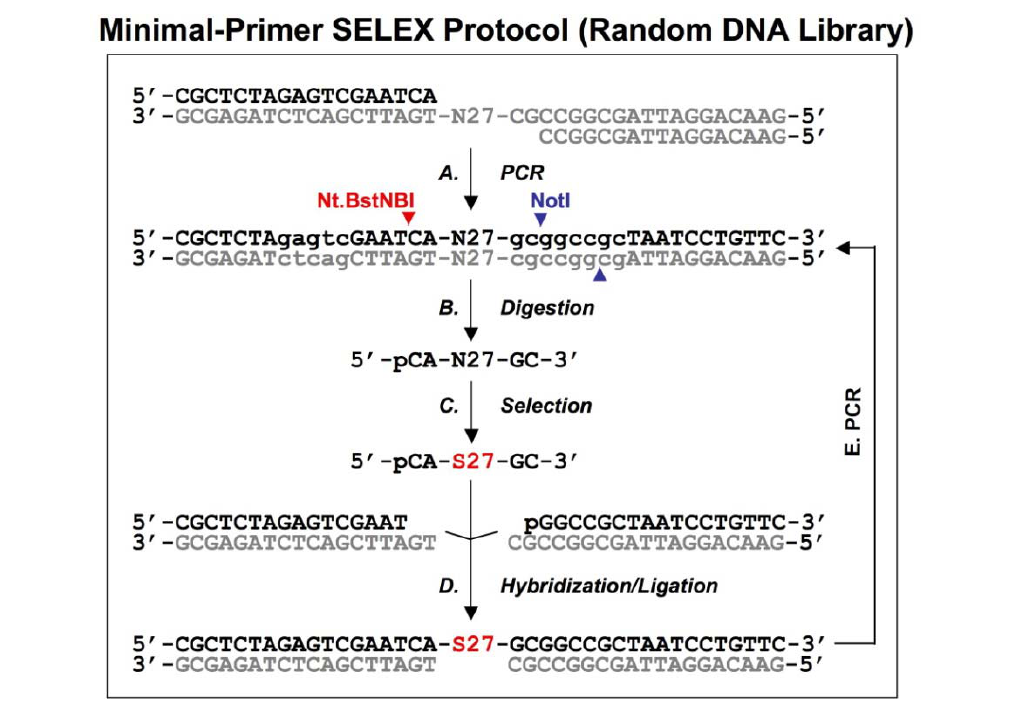
Figure 7 . Schematic representation of the minimal-primer random DNA library selection. Oligonucleotides are annealed together, and subjected to PCR amplification to yield a dsDNA library (A). The primer-less ssDNA library is from Nt.BstNBI /NotI digestions and gel-purification (B), the Nt.BstNBI and NotI recognition sequences are indicated in lower case and their cutting sites are indicated by red and blue arrowheads, respectively. After selection (C), the selected library is ligated with 5’ and 3’ duplexes to re-generate the primer regions (D), and finally re-amplified by PCR (E) for the next round of